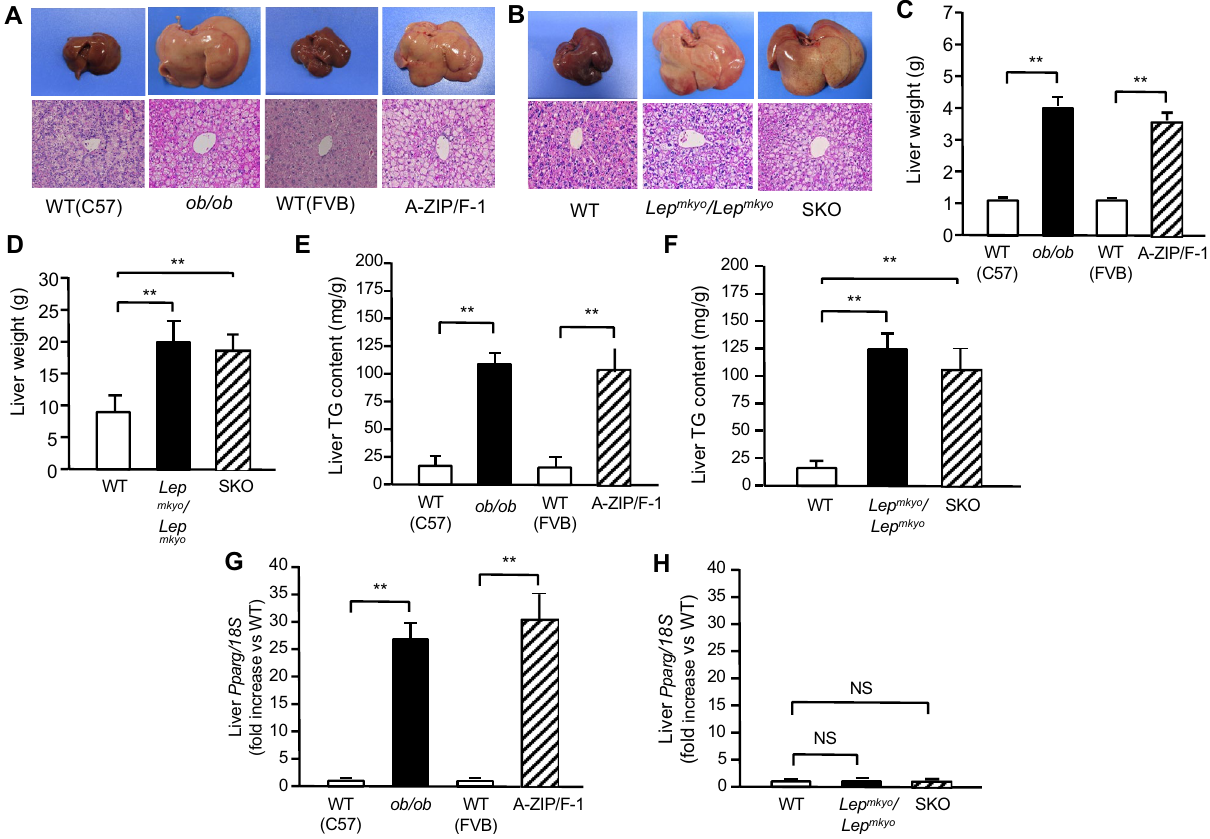
Figure 1. Liver phenotype and liver Pparg mRNA expression in mouse and rat models of leptin deficient obesity and generalized lipodystrophy. ( A , B ) Macroscopic (top) and histological images (bottom) of the liver, ( C , D ) liver weight, ( E , F ) liver triglyceride content and ( G , H ) liver Pparg mRNA expression in 16 weeks old male C57B/6J WT, ob/ob , FVB/N WT and A-ZIP/F-1 mice ( A , C , E , G ) and F344 WT, Lep mkyo /Lep mkyo and SKO rats ( B , D , F , H ). For histological examination, hematoxylin and eosin staining was used. Original magnification of × 200 is shown. Pparg mRNA expression levels were normalized by 18S. Values are means ± SEM ( n = 10 per group). * P < 0.05, ** P < 0.01, NS, not significant (one-way ANOVA followed by Tukey’s